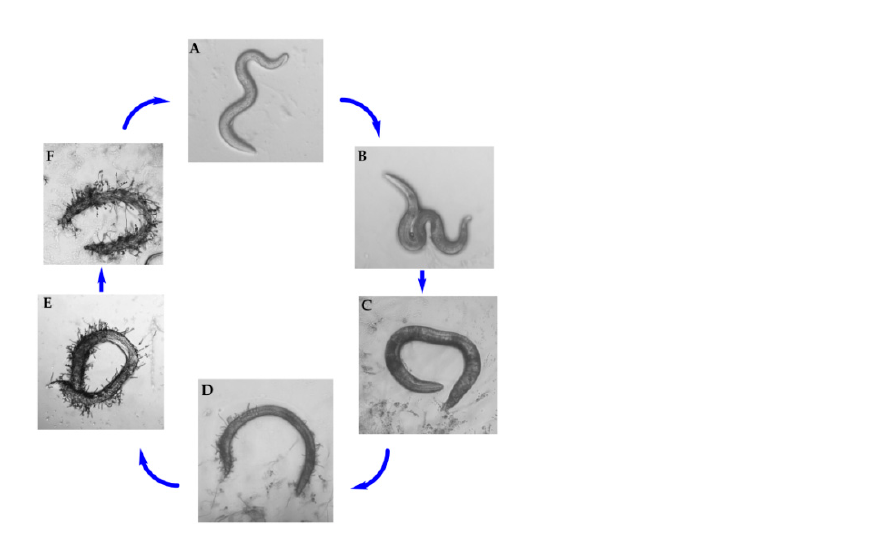
Figure 3. Infection Process of C. elegans by Spores of D. coniospora YMF1.01759. 3.2. Nematicidal Activity of Medium Screening Extracts Among the extracts from five media of D. coniospora YMF1.01759, the extract from the SDAY medium exhibited strong nematicidal activity against M. incognita : 99.1% mortality at a concentration of 5 mg mL − 1 at 72 h. The other four extracts had no evident